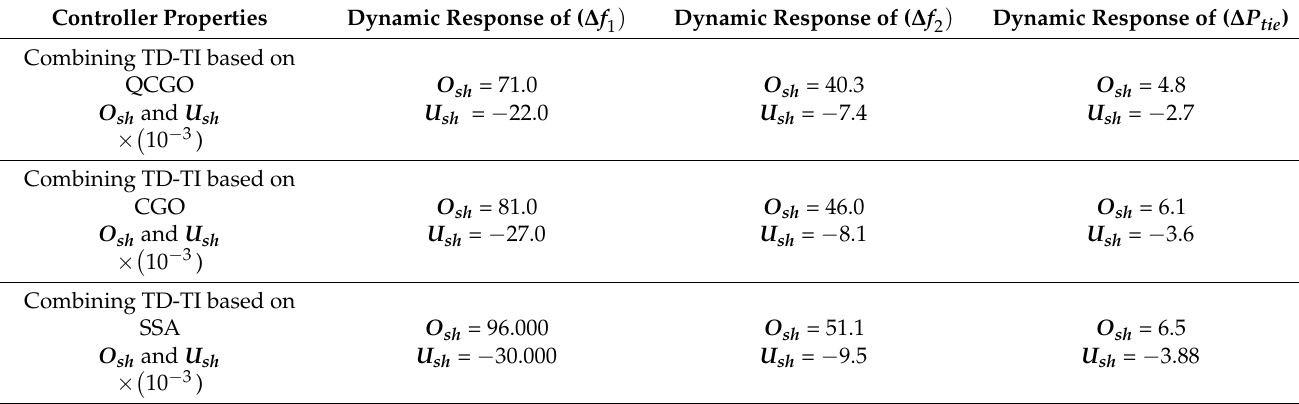
Table 18. The transient response specifications of the presented system for case B.1.